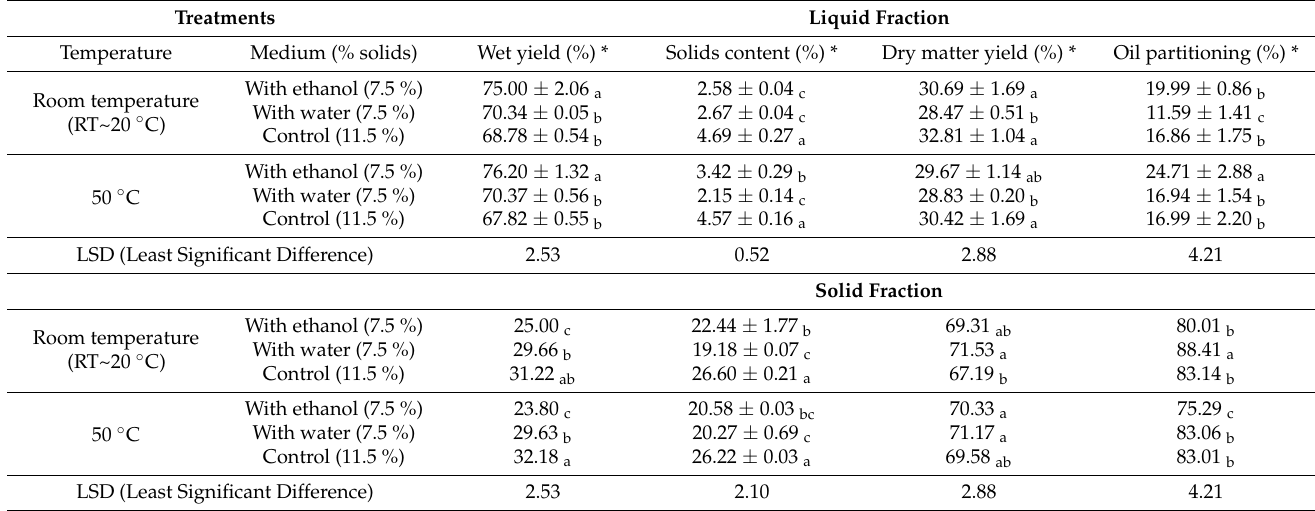
Table 3. Yield and partition of oil in liquid and solid fractions corresponding to whole